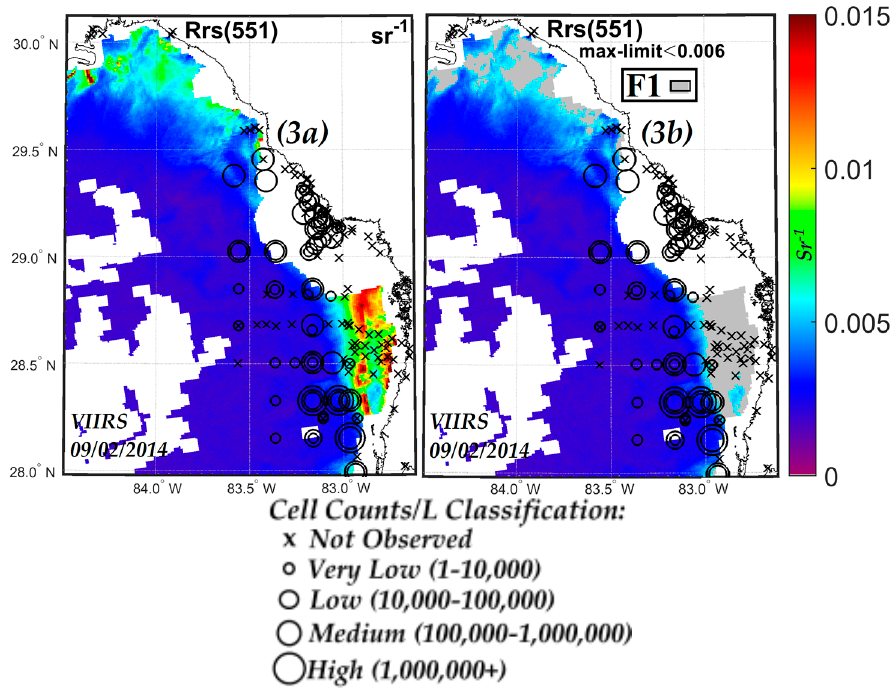
Figure 3. ( a ) VIIRS Rrs 551 image; ( b ) Residual Rrs 551 image after F1 mask (dark grey) is applied showing residual { Rrs 551 ≤ 0.006 sr − 1 }. Note that these images are overlaid with NOAA-HABSOS KB Cell Counts, from Figure 2 above. White areas represent cloud cover or invalid data.